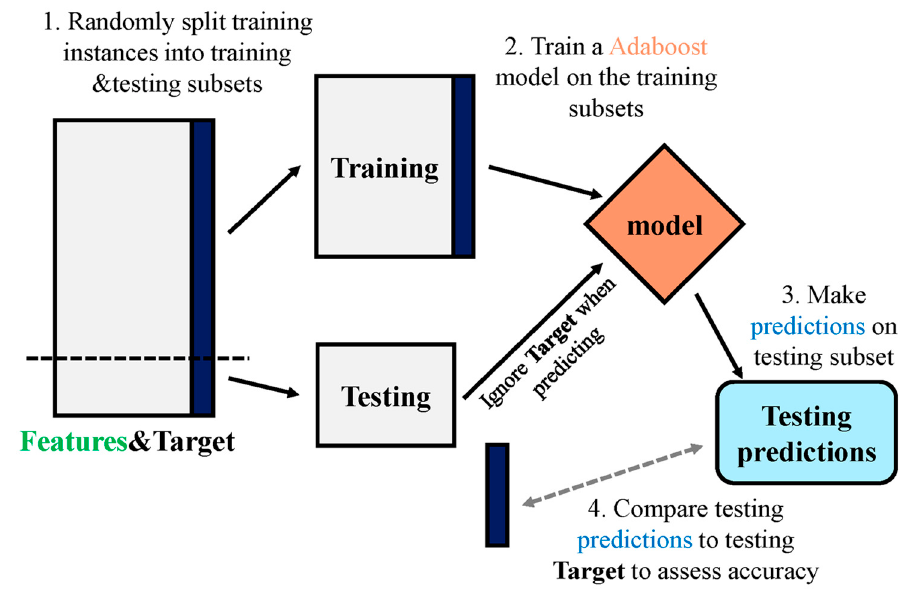
Figure 6. Complete process of prediction via AdaBoost algorithm [93].